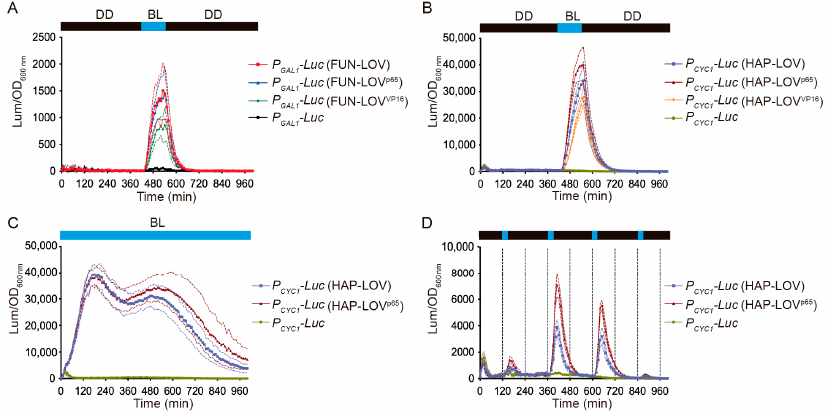
Figure 4. Normalized luciferase expression in the context of FUN-LOV and HAP-LOV systems carrying different activation domains (ADs). Yeast strains carrying the FUN-LOV ( A ) or HAP-LOV ( B ) systems and containing different ADs (VP16 or p65) were subjected to a blue-light (BL) pulse of 120 min. Similarly, yeast strains carrying the HAP-LOV and HAP-LOV p65 systems were subject to constant BL ( C ) and BL pulses of 30 min every 4 h ( D ). In all panels, the yeast strains carrying the GAL1 ( P GAL1 ) or CYC1 ( P CYC1 ) promoters controlling luciferase ( Luc ) expression, but lacking the corresponding switches, were used as controls. The graphs show the average of normalized luciferase expression in six biological replicates, with the standard deviation represented as regions between dashed lines.